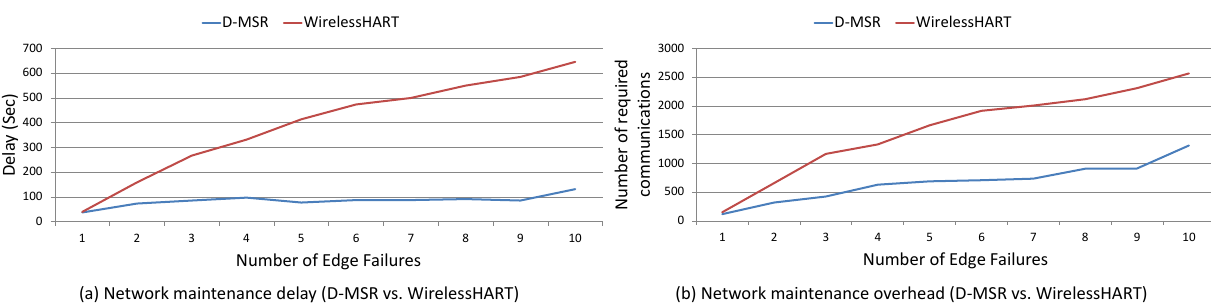
Figure 32. Network maintenance delays ( a ) and overhead ( b ) (D-MSR vs.